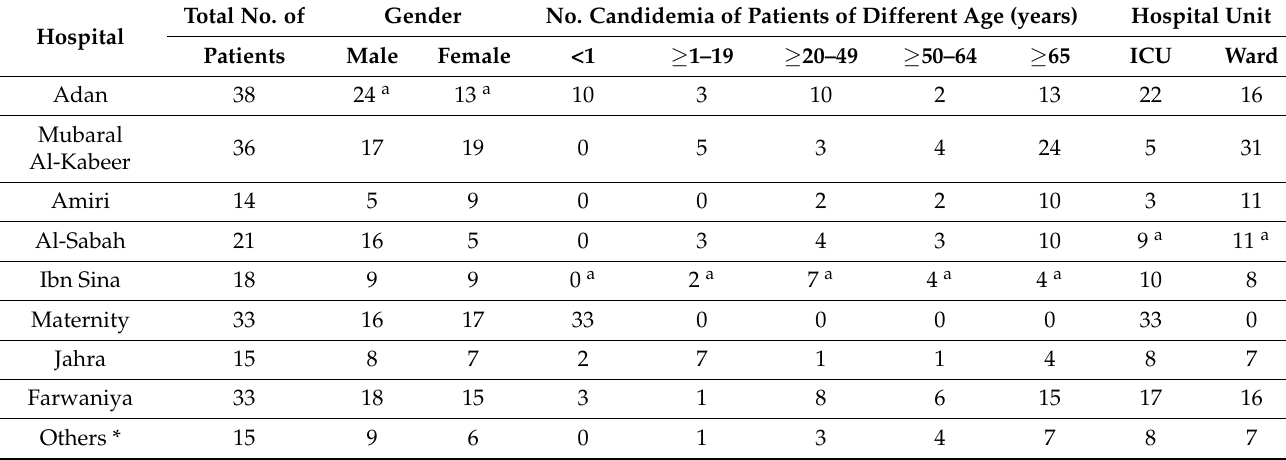
Table 3. Distribution of candidemia patients in eight major hospitals and other tertiary care hospitals in Kuwait in 2018. Total No. of Hospital